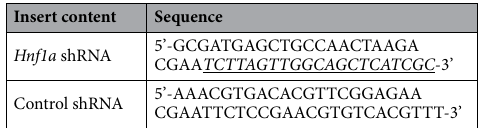
Table 4. Sequence of the control and Hnf1a shRNA.